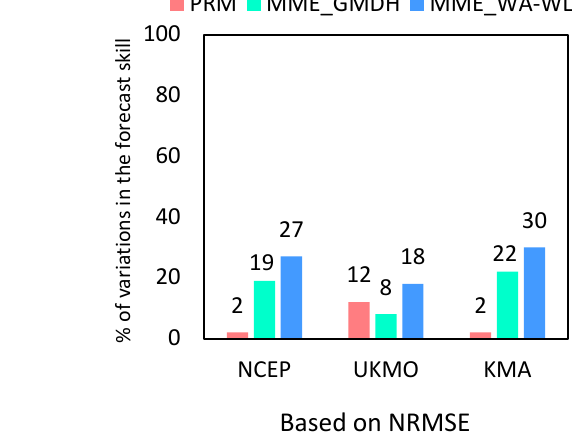
Figure 5. The percentage of variations in improving the forecast skill of the NWP models based on post-processing approaches.